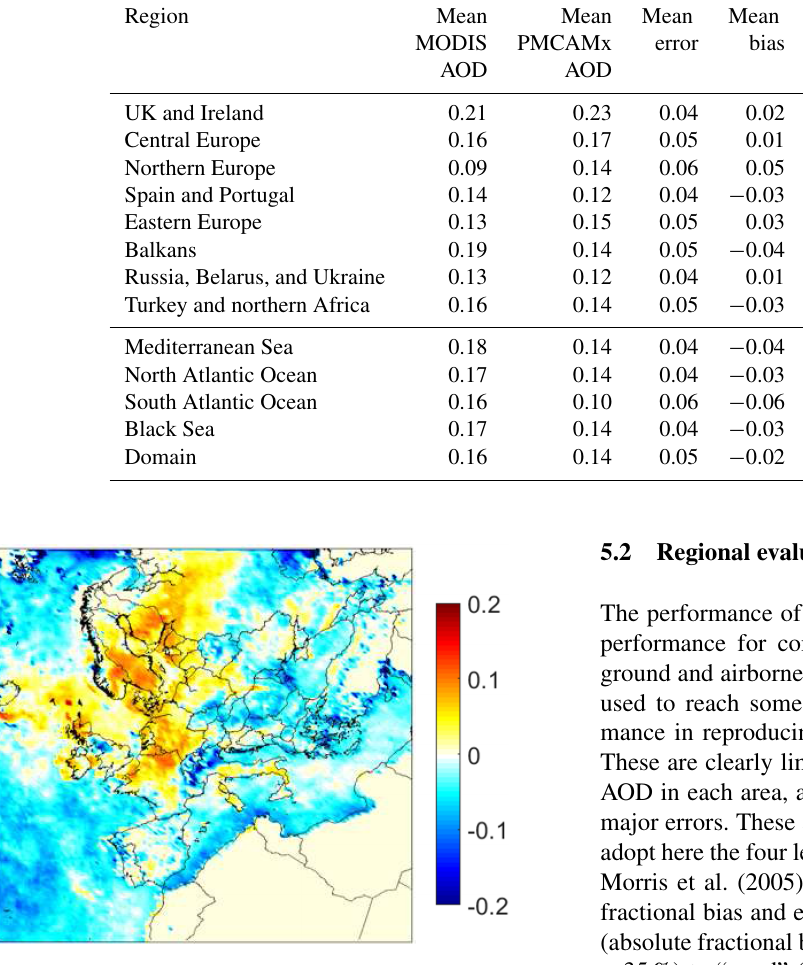
Figure 4. Difference of the PMCAMx from MODIS (QAC ≥ 1) monthly mean AODs during May 2008. Positive means that PM- CAMx overpredicts AOD compared to MODIS. There were not enough dust-screened AOD retrievals for the model evaluation in the white areas in northern Africa and in the Middle